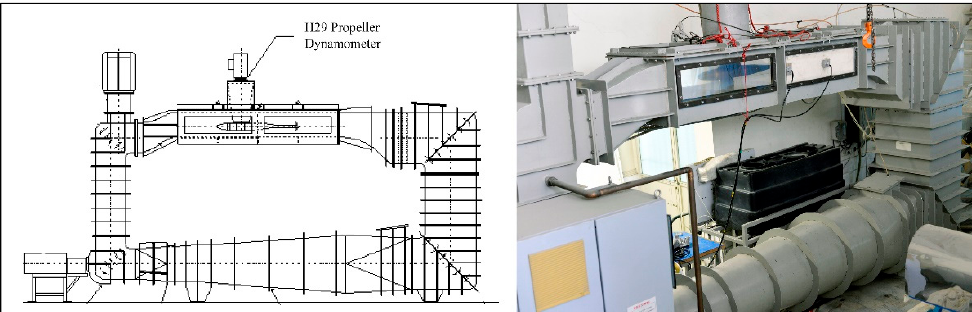
Figure 4. Cavitation Tunnel of Sharif University of Technology.